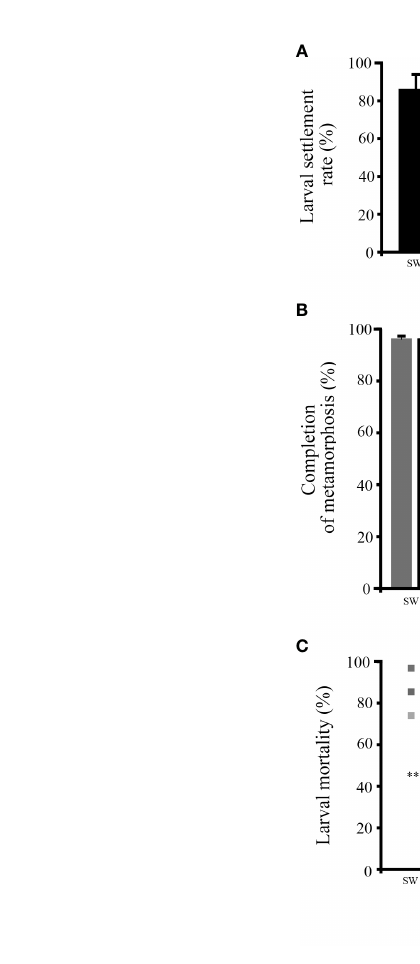
FIGURE 1 Bugulina neritina larval settlement bioassay for butenolide treatment. (A) Larval settlement rate after 3 hours of BU treatment. “ * ” indicates ANOVA p value < 0.001. (B) Rate of metamorphosis at 24 hours after the initiation of the bioassay experiment. Larvae in BU treatment groups were treated with BU for 3 hours, after which BU was replaced with autoclaved fi ltered seawater and incubated for 21 hours in dark until observation. “ * ” indicates ANOVA p value < 0.001. (C) Larval mortality at 3, 9 and 24 hours with different BU concentration treatment. “ * ” and “ ** ” indicate ANOVA p value <0.01 and <